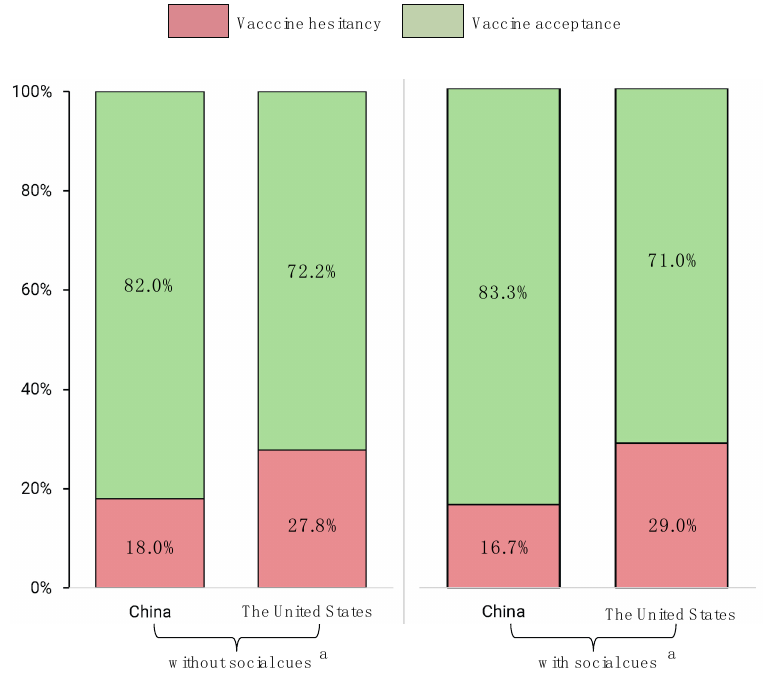
Figure 2. COVID-19 vaccination acceptance comparison between China and the United States after propensity score matching. a Social cues in this study means social factors that potentially impact respondents’ acceptance, i.e., recommendations from friends, family members, or employers, etc.